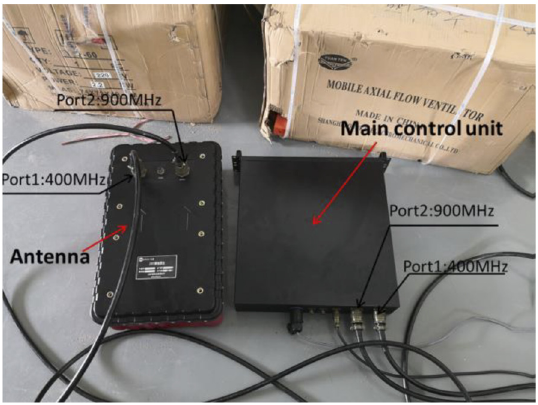
Figure 3. The GPR antenna is designed with two frequency-independent signal channels of 400 MHz and 900 MHz.